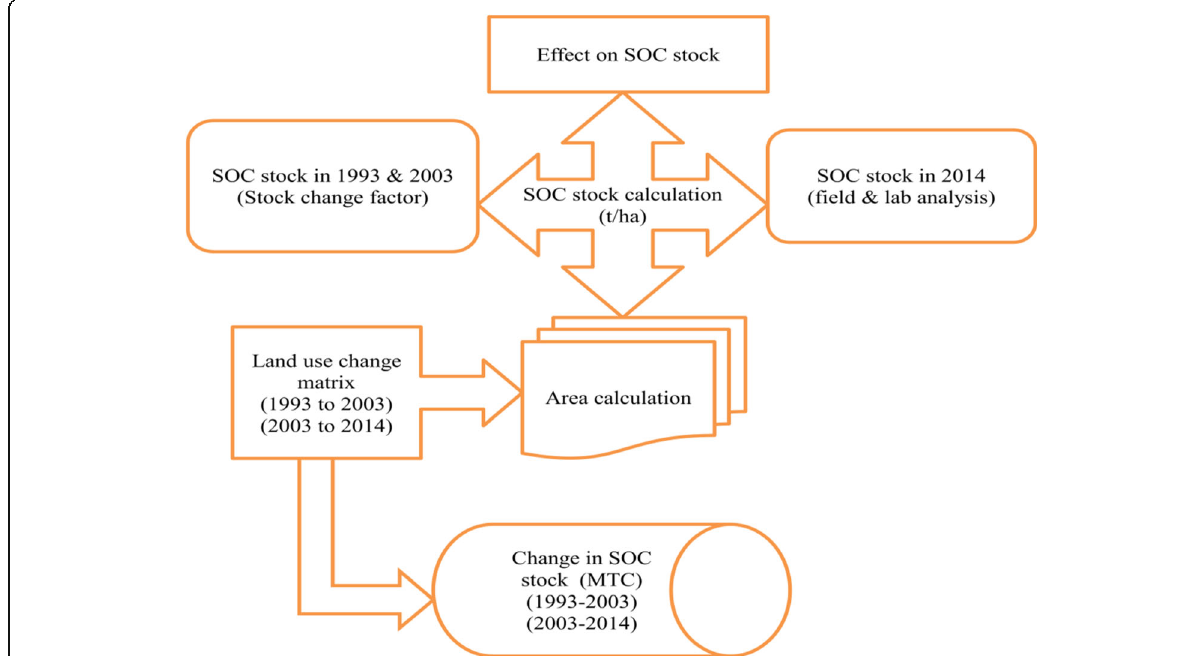
Fig. 3 Scheme to determine effect of Land use change on SOC stock